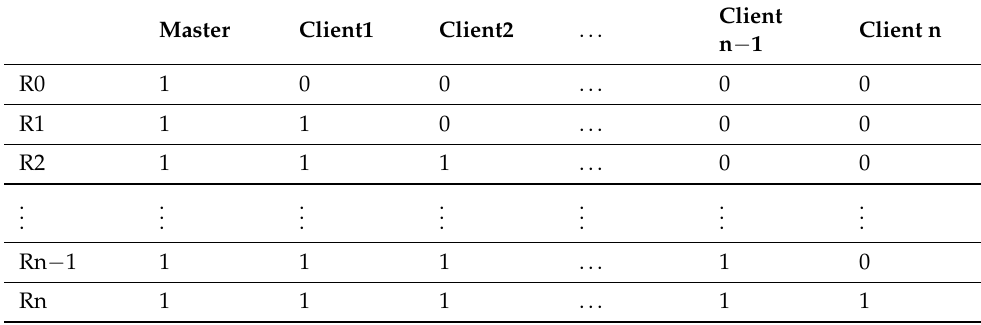
Table 4. The 3rd